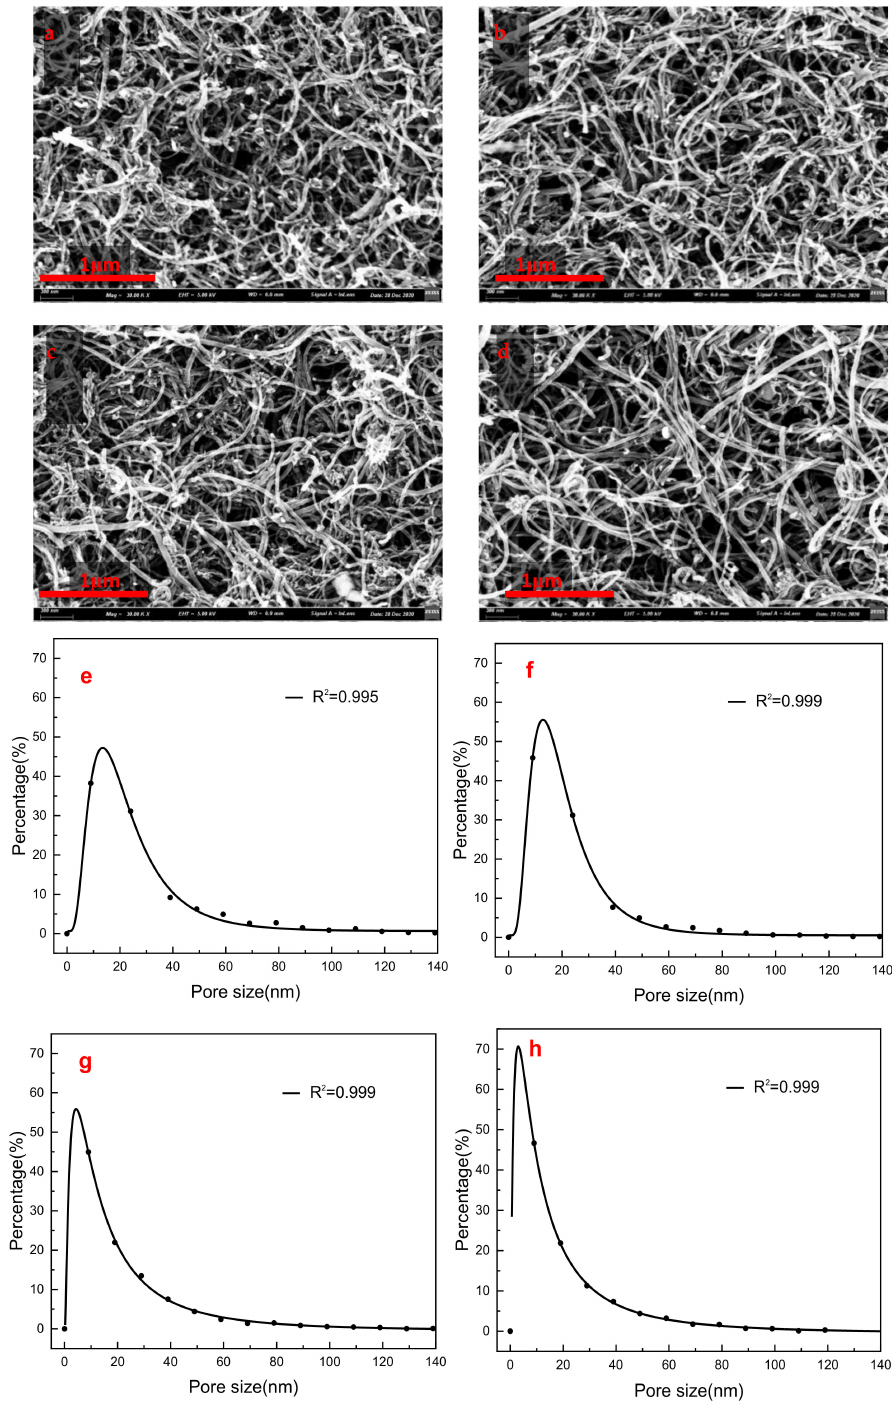
Figure 8. SEM and pore size distribution of PEG non-covalent-functionalized MWCNT membranes. ( a ) and ( b ) SEM images of raw MWCNT/MWCNT- COOH membranes respectively; ( c ) and ( d ) SEM images of MWCNT-PEG and MWCNT– COOH - PEG membranes respectively; ( e ) and ( f ) the pore size distribution diagram of raw MWCNT/MWCNT– COOH membranes respectively; ( g ) and ( h ) the pore size distribution of MWCNT–PEG and MWCNT– COOH –PEG membranes respectively, the curve in the figure is a fitted lognormal distribution